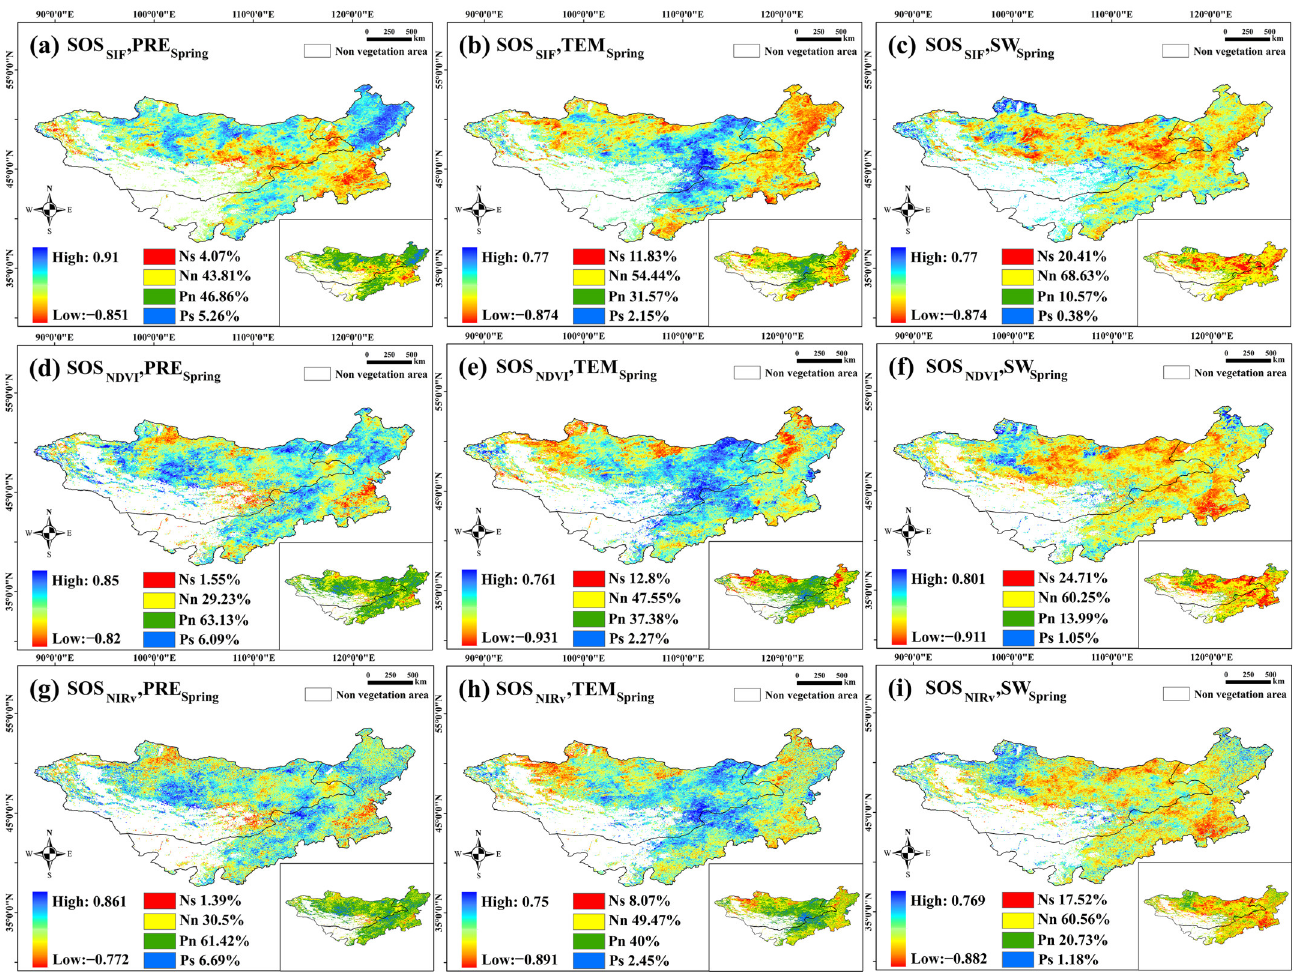
Figure 9. Spatial distributions of the correlations between temperature (TEM Spring ), precipitation (PRE Spring ), soil moisture (SW Spring ) and three types of SOS in (spring).